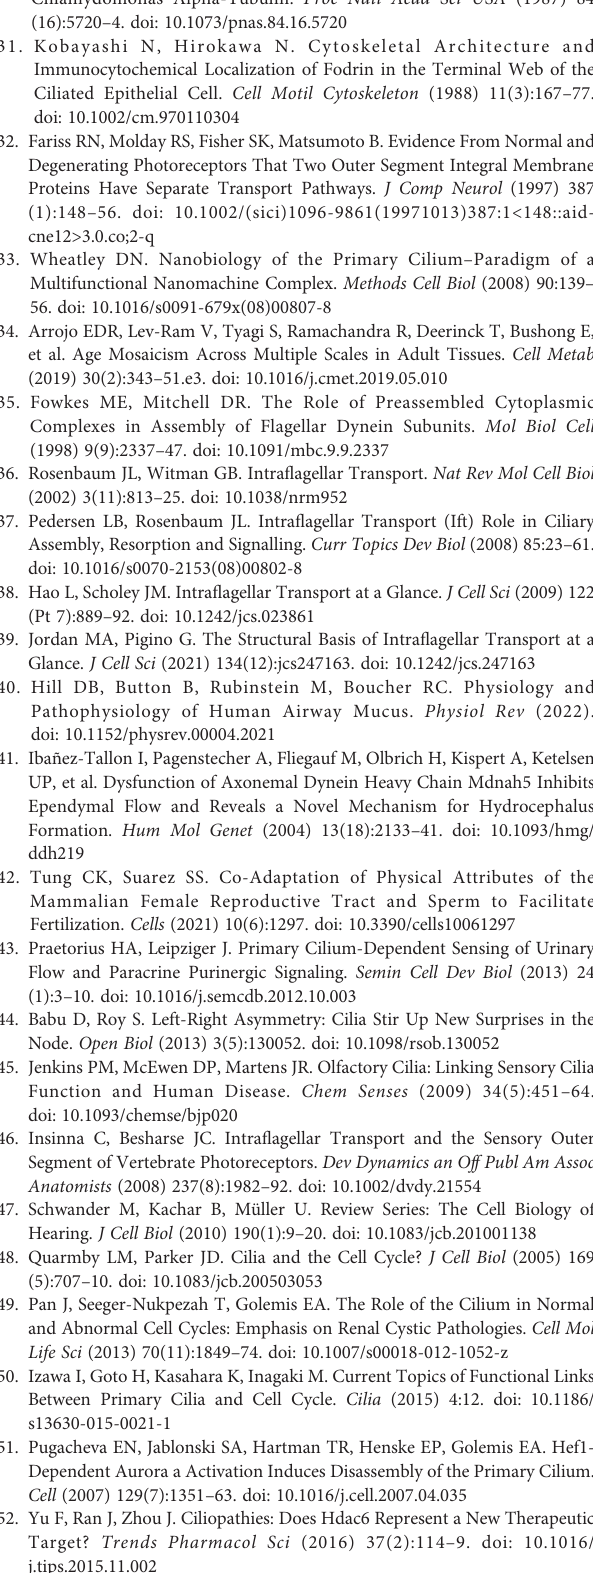
8. Fliegauf M, Benzing T, Omran H. When Cilia Go Bad: Cilia Defects and Ciliopathies. Nat Rev Mol Cell Biol (2007) 8(11):880 – 93. doi: